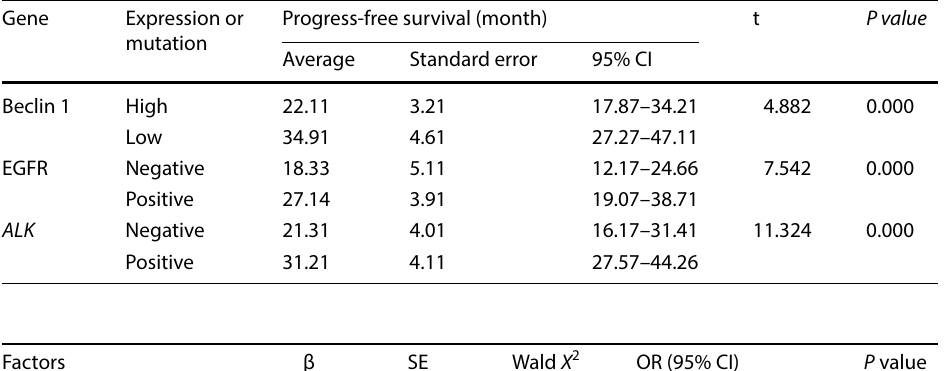
Table 4 Multivariate survival analysis of factors associated with progress-free survival in lung cancer patients